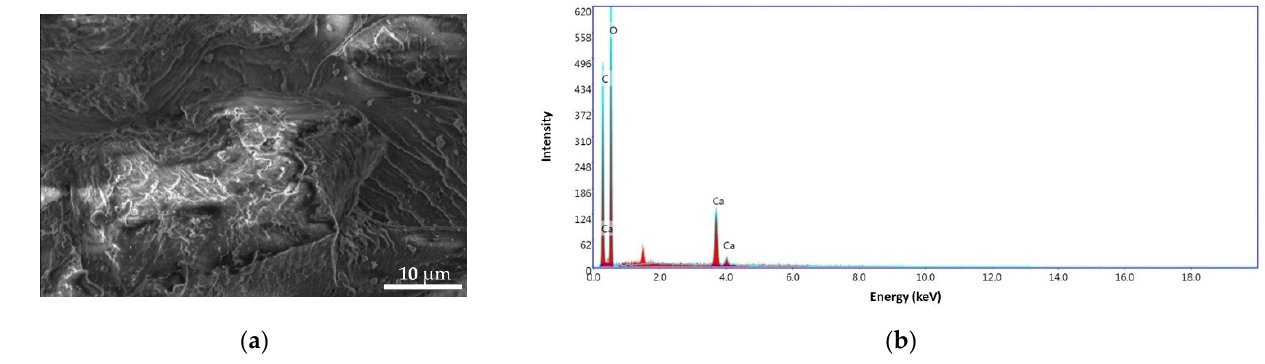
Figure 12. SEM images for ALG microbeads at 8000× ( a ) and the EDS pattern ( b ).